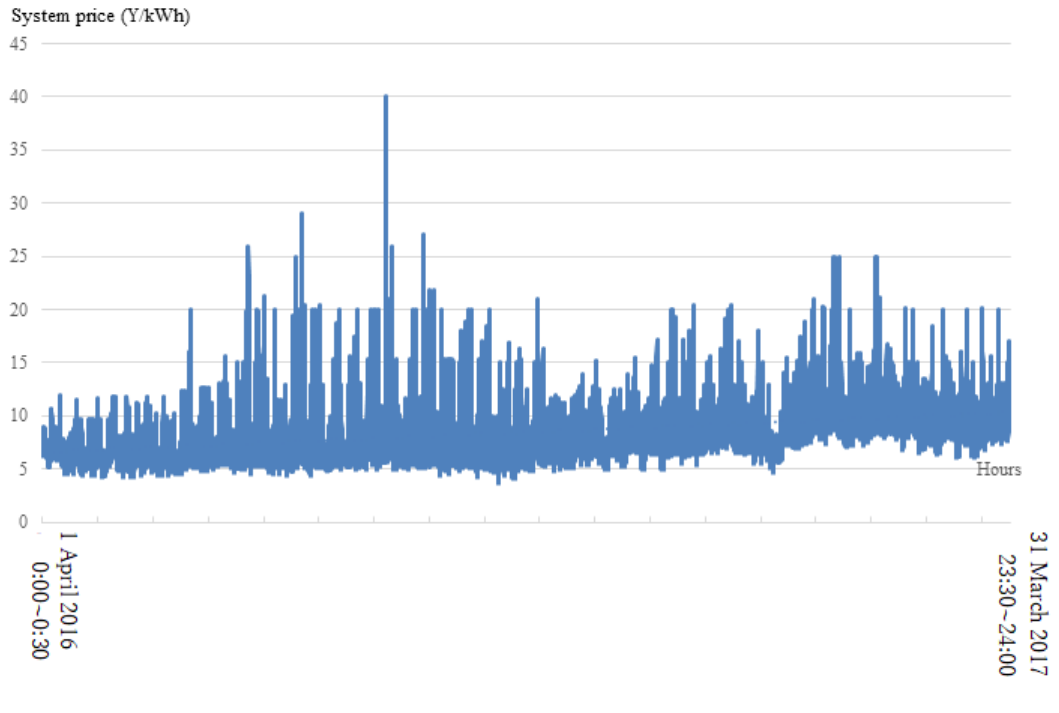
Figure 5. Spot Price of the JEPX (1 April 2016 to 31 March 2017, created based upon the data from JEPX website [19]).